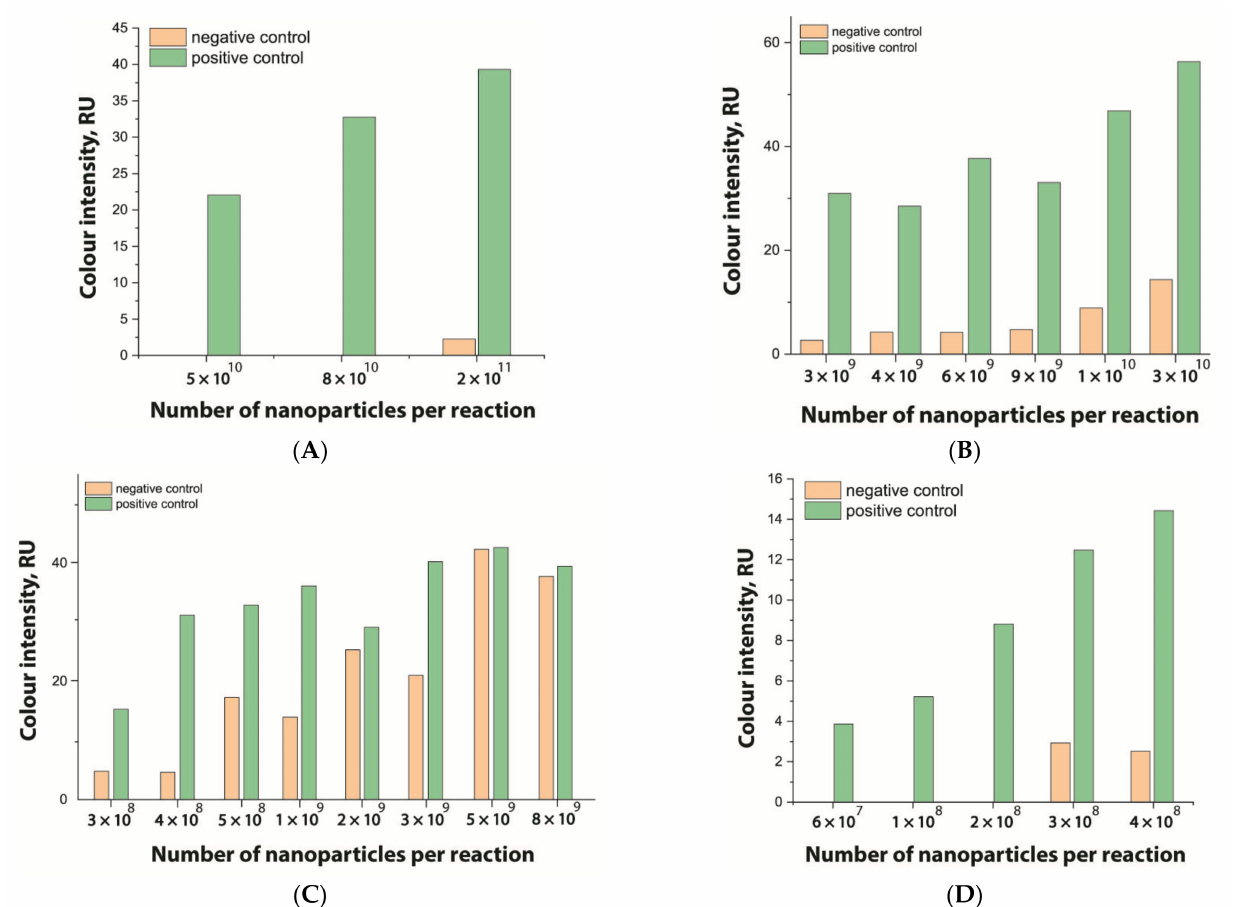
Figure 6. Optimization of the number of nanoparticles per reaction in LFIA based on CN-95 nitrocellulose membrane with ( A ) Au NPs, ( B ) Au@Pt NPs, ( C ) LPs, ( D ) MPs. The negative control is buffer without bacterial cells, and the positive control is buffer with 1 × 10 7 CFU/mL E. amylovora